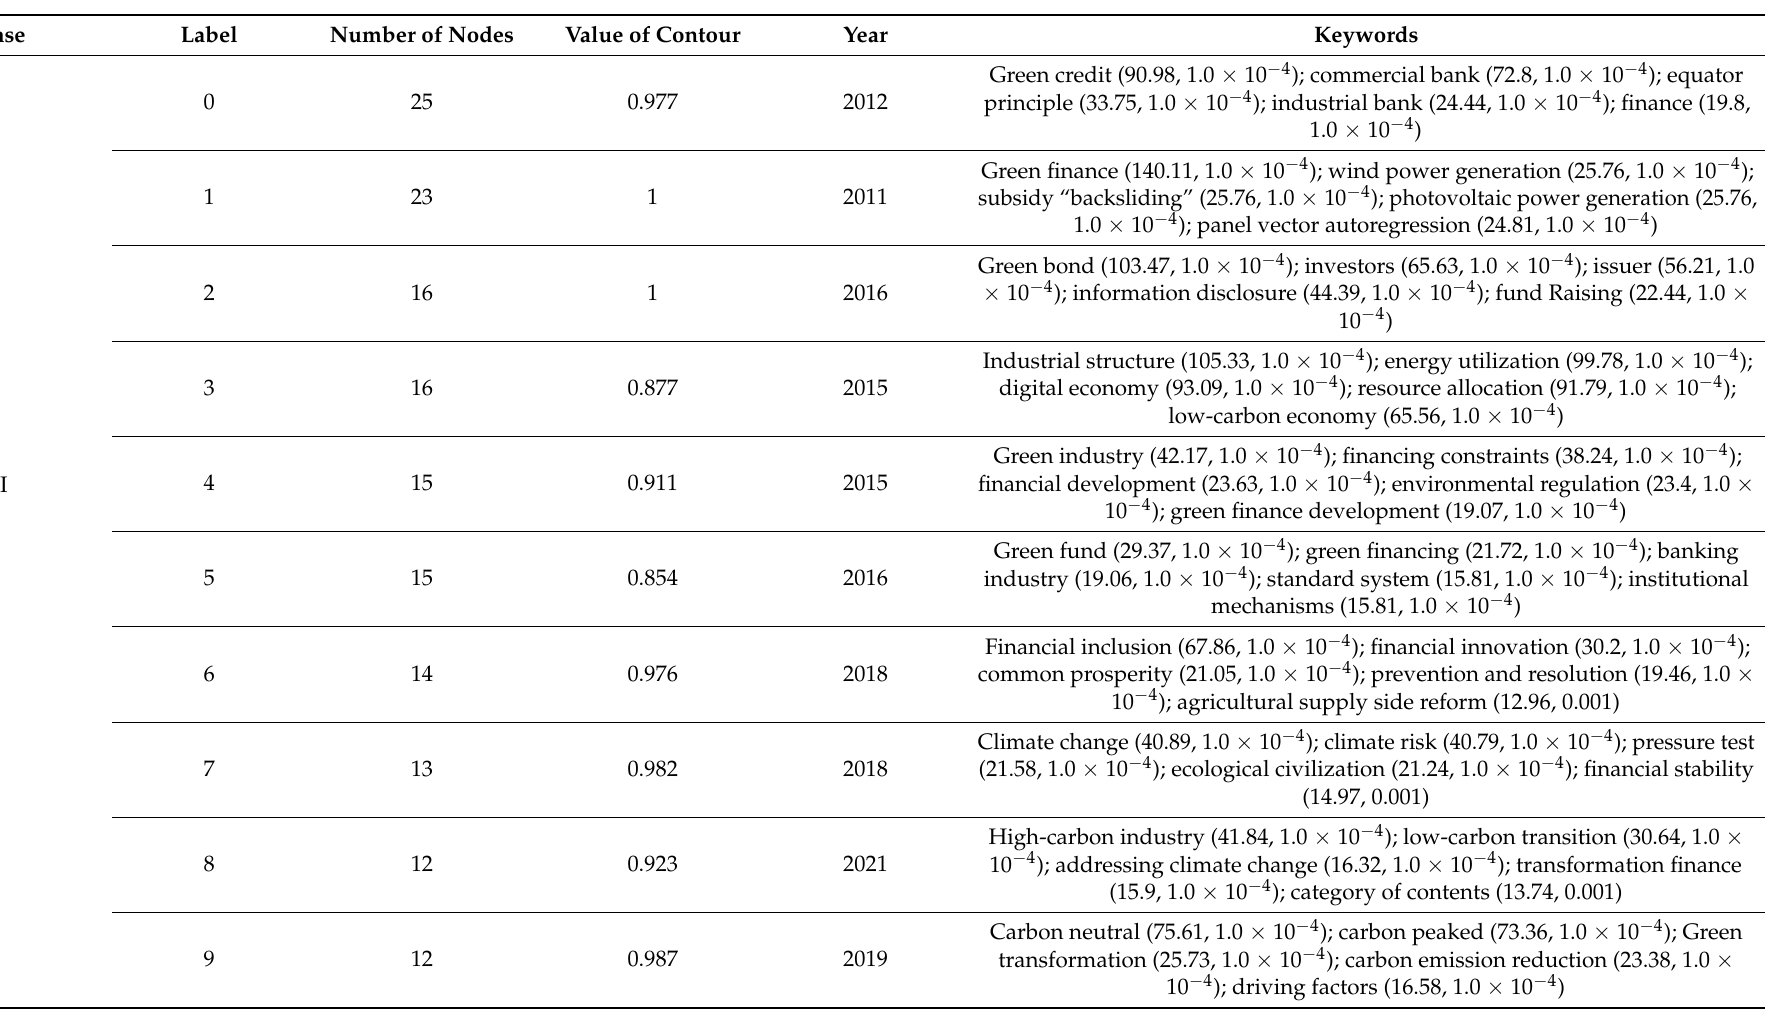
Table 5. Clustering summary and